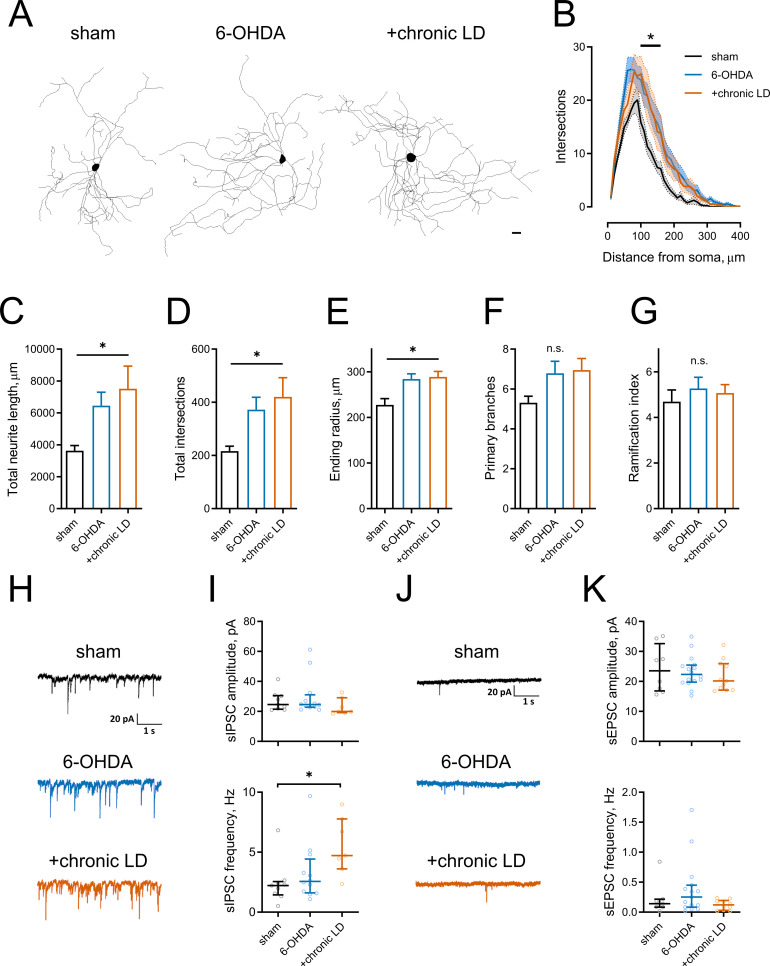
Morphological parameters and synaptic inputs in ChIs from control, 6-OHDA lesioned and chronic LD mice.(A–G) Sholl analysis of ChI morphology. Cells were filled with biocytin during physiological recordings, fixed, and imaged for biocytin labeling by confocal microscopy. (A) Representative maximum projection images from three dimensional reconstructions of ChIs, scale bar = 20 μm. (B) Sholl analysis of reconstructed ChIs, solid line denotes mean intersections at indicated distance from soma, shaded area shows SEM, p<0.05 (*) for sham vs. 6-OHDA and sham vs. chronic LD, Dunnett’s multiple comparison test following two-way ANOVA, p=0.0074 for interaction between treatment group and distance from soma. (C–G) DA lesion caused significant increase in total dendrite length (C), total number of intersections (D) and ending radius (E), whereas the number of primary dendrites (F) and ramification index (G) were similar between the groups, p<0.05 (*) 6-OHDA and +chronic-LD vs. Sham, Kruskal-Wallis test with Dunn’s multiple comparison. For A-G sham n = 13 neurons/7 mice, 6-OHDA n = 28 neurons/14 mice, chronic-LD n = 19/10 mice. (H and J) Representative traces of spontaneous inhibitory postsynaptic currents (sIPSCs) and excitatory postsynaptic currents (sEPSCs) of ChIs from sham, 6-OHDA and chronic LD mice. (I) Amplitudes of sIPSCs were similar, but their frequency was increased in chronic L-DOPA group. Sham n = 9 neurons/5 mice, 6-OHDA n = 12 neurons/6 mice, chronic-LD n = 7 neurons/3 mice. p<0.05 (*) by Kruskal-Wallis test followed by Dunn’s multiple comparison test. (K) There were no changes in amplitude or frequency of sEPSCs. Sham n = 8 neurons/4 mice, 6-OHDA n = 16 neurons/7 mice, chronic-LD n = 11 neurons/6 mice.Figure 2—source data 1.Individual neuron data and statistics for all panels.